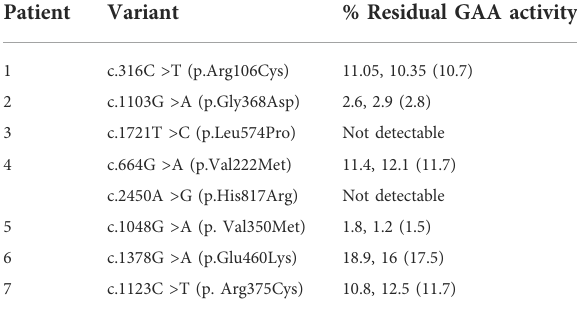
TABLE 3 GAA enzyme activity of each variant tested in the HEK293cell-basedfunctionalanalysisassay.Valuesinparenthesis are average of 2